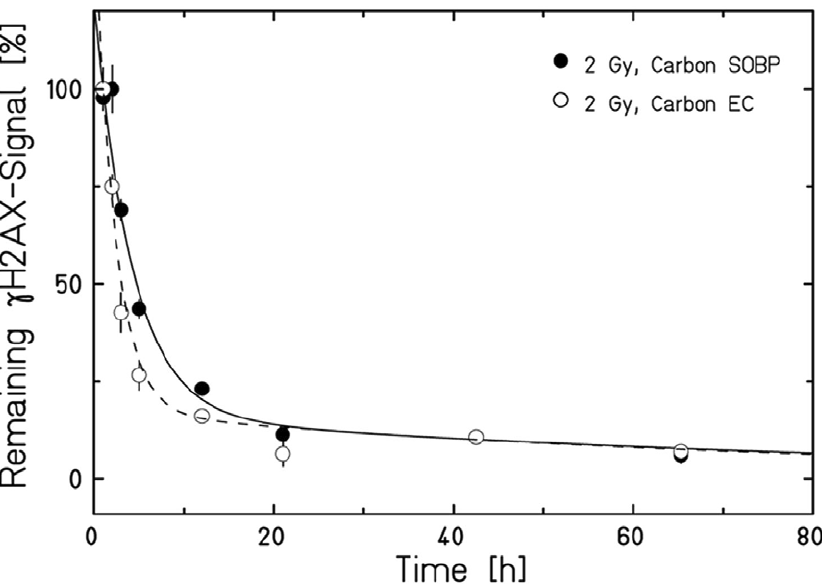
Figure 4. DNA DSB repair kinetics of human fibroblasts exposed in the entrance channel (EC) or SOBP (2.4 cm width at a water-equivalent depth of 16 cm, two opposite fields, 2 Gy dose). Figure from [47], distributed under Creative Commons CC-BY.